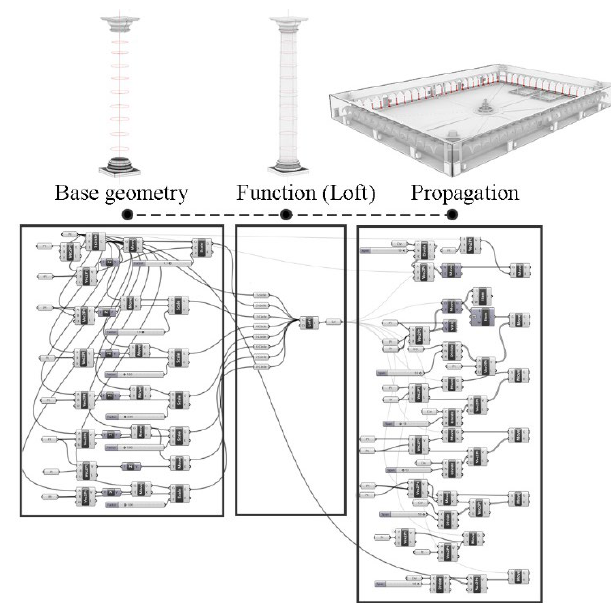
Figure 7. Construction of the column’s shaft by visual programming: base geometry, loft function and propagation.